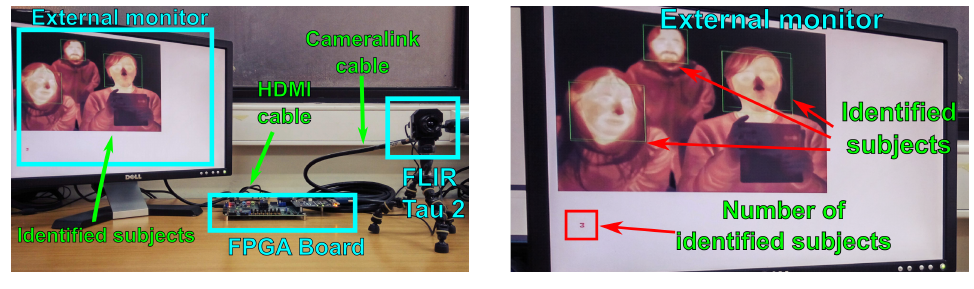
Figure 14. Experimental setup to test the face recognition algorithm. An FPGA board receives IR images from a FLIR Tau 2 camera core and uses a HOG algorithm to detect face locations. The FPGA emulates the smart pixel array and the digital coprocessor. A monitor connected to the FPGA displays the image acquired by the smart pixel array, and the location and number of identified faces. The FPGA sends the labels of the recognized faces to a remote computer via Ethernet.